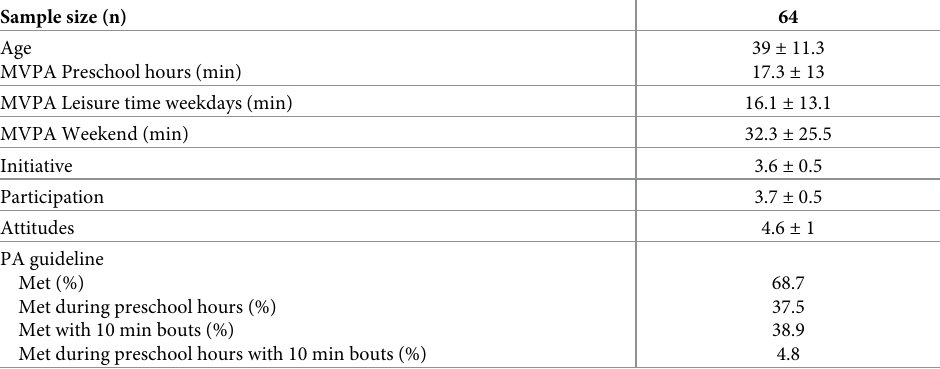
Table 2. Descriptive characteristics of preschool staff: min in MVPA and fulfilment of the global PA guideline. Sample size